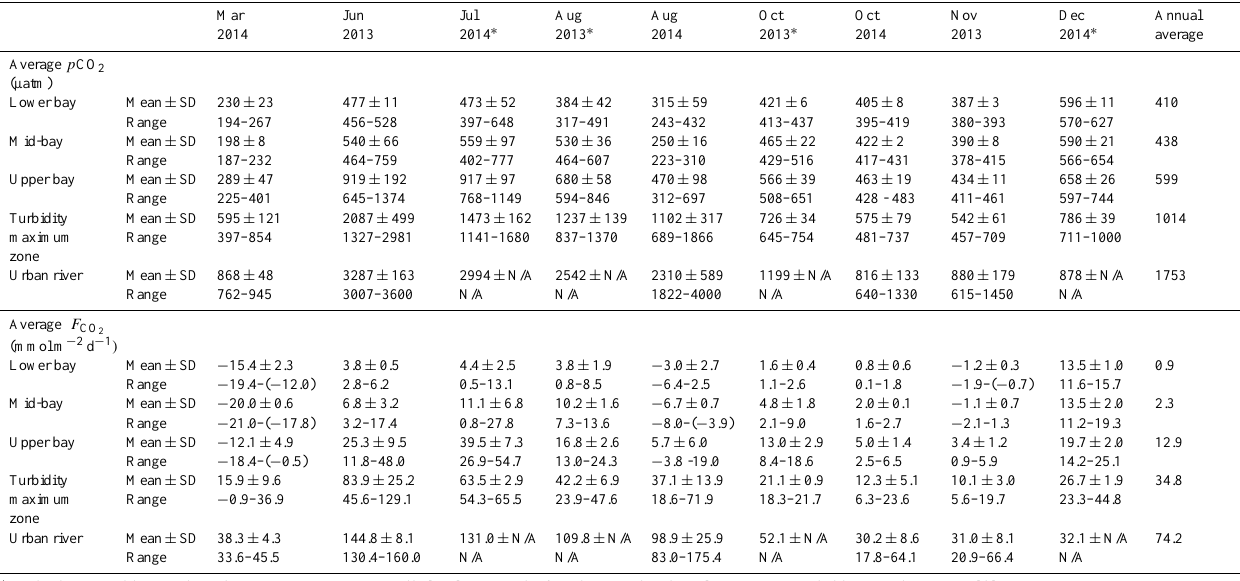
Table 2. Area average, standard deviation, and range of p CO 2 and CO 2 flux ( F CO each